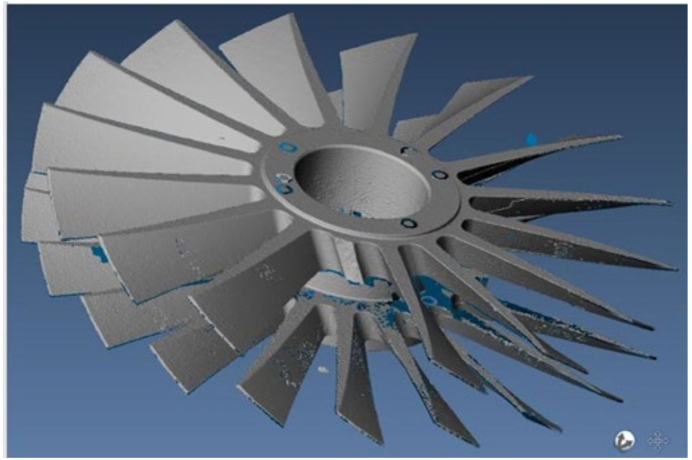
Figure 4. Scanner error (noise) repair and surface fitting after scanning of the first and second turbine